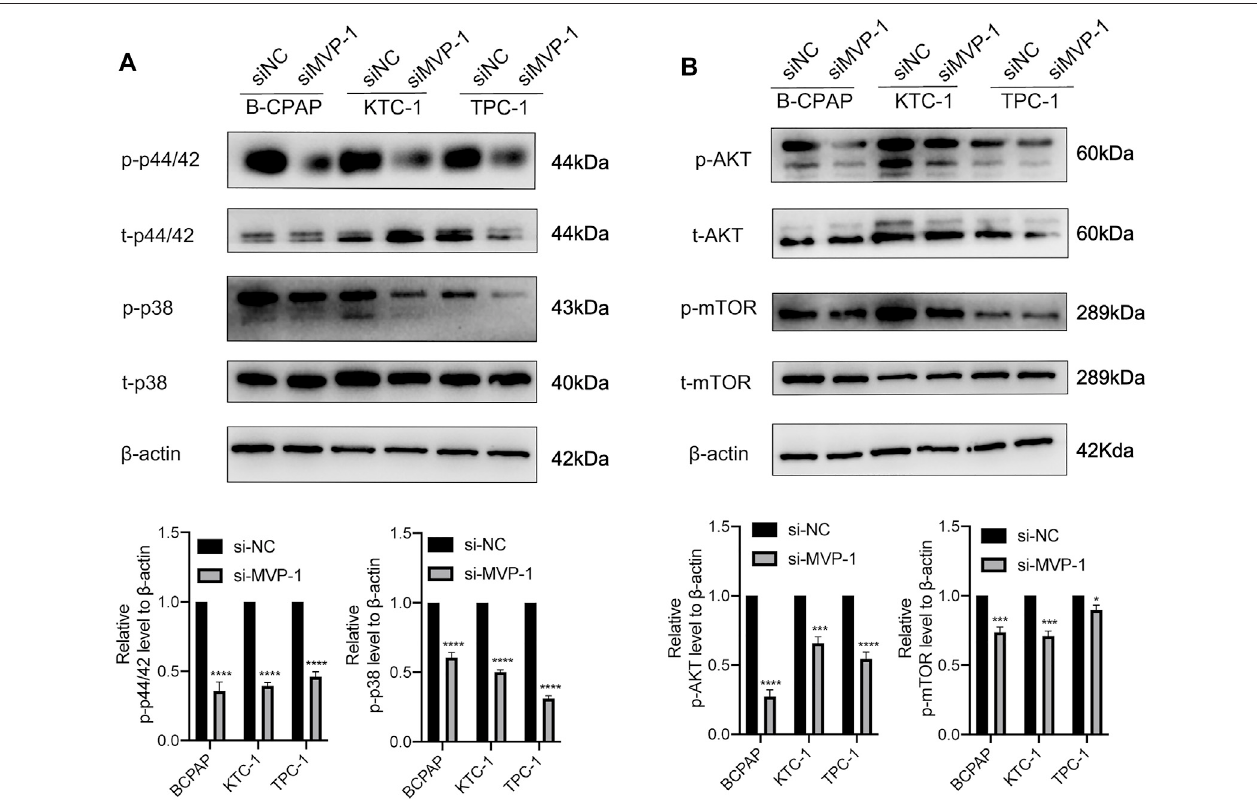
FIGURE9 | MVPpromotes the activitiesof the MAPK/ERK and PI3K/AKT/mTOR cascades. The antibodies against MVP, phospho-p44/42 (p-p44/42), total p44/ 42(t-p44/42),phospho-p38(p-p38),totalp38(t-p38),phospho-AKT Ser473 (p-AKT Ser473 ),totalAKT(t-AKT),phospho-mTOR(p-mTOR),andtotalmTOR(t-mTOR) were selected to evaluate the impact of MVP knockdown on the activities of (A) MAPK/ERK and (B) PI3K/AKT/mTOR cascades. GAPDH was used as the loading control. Representative images of Western blotting are showed in the upper panel. Quantitative analysis of Western blotting is displayed in the lower panel. All assays were independently repeated at least three times. Data are presented as the mean ± SD. * p < 0.05, ** p < 0.01, *** p < 0.001, **** p < 0.0001.